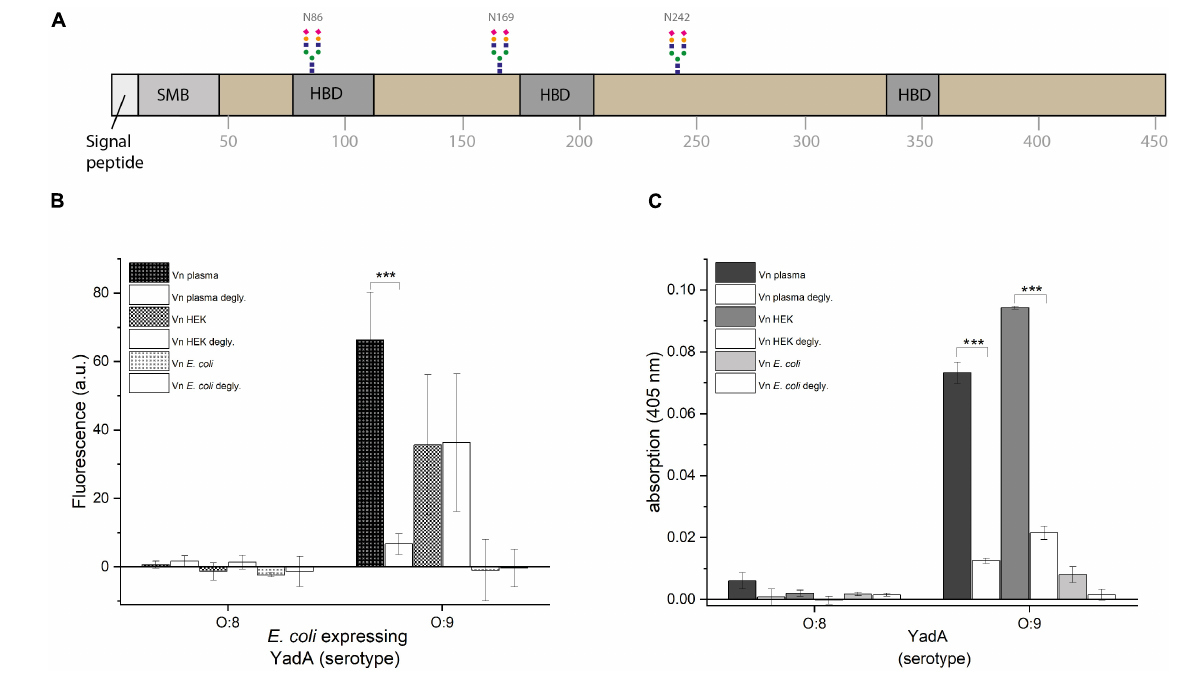
FIGURE 2 | YadA O : 9 binding to deglycosylated Vn is reduced. (A) Schematic representation of full-length Vn. Vn has three N-linked glycosylations in positions N86, N169, and N242. (B) Whole-cell binding assay to glycosylated and deglycosylated Vn. (C) Binding assay using purified YadA head domains to glycosylated and deglycosylated Vn. Significance levels are indicated with * p < 0.05, ** p < 0.01, *** p <